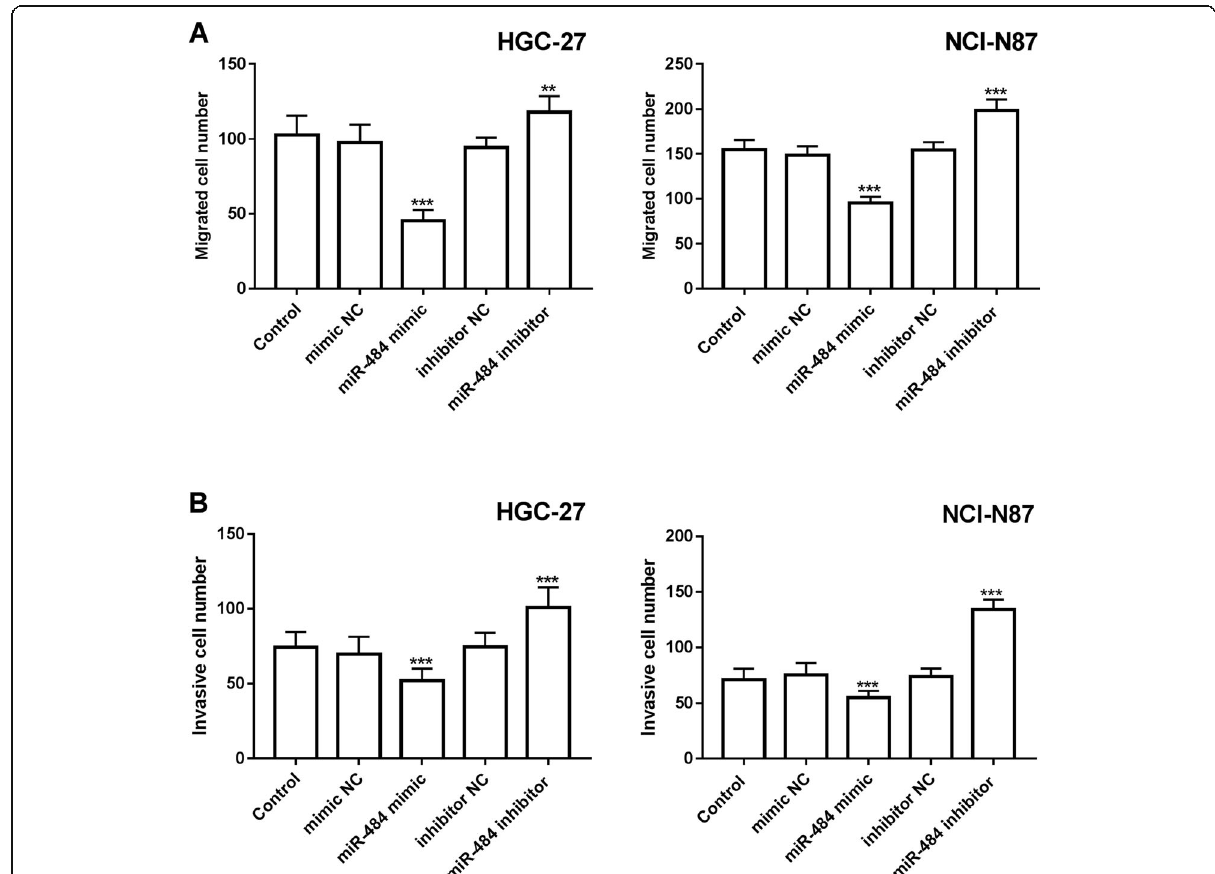
Fig. 4 Effect of miR-484 on the migration and invasion of HGC-27 and NCI-N87. a . Knockdown of miR-484 enhances the migration of gastric cancer cells (** P < 0.01, *** P < 0.001). b . Reduction of miR-484 promotes the invasion of gastric cancer cells (*** P <